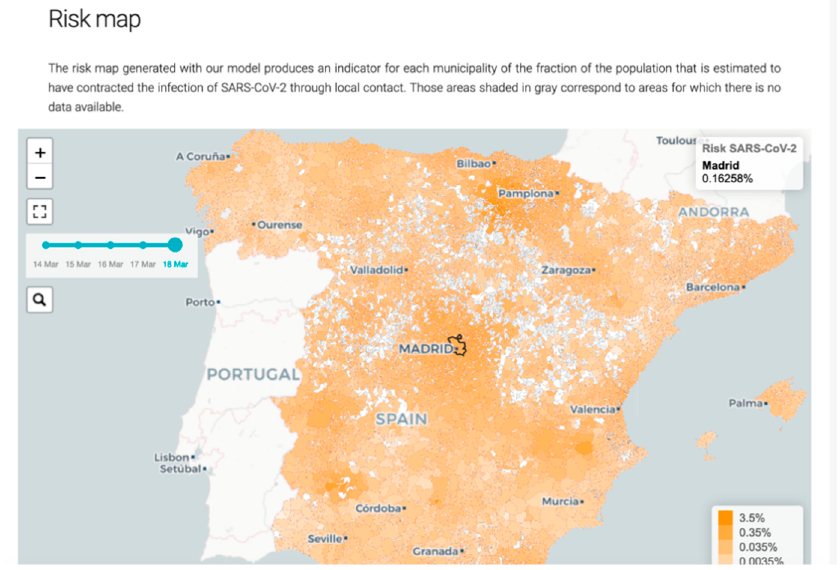
Figure 11. COVID-19 risk map in Spain [68]. Mathematics 2020 , 8 , x FOR PEER REVIEW